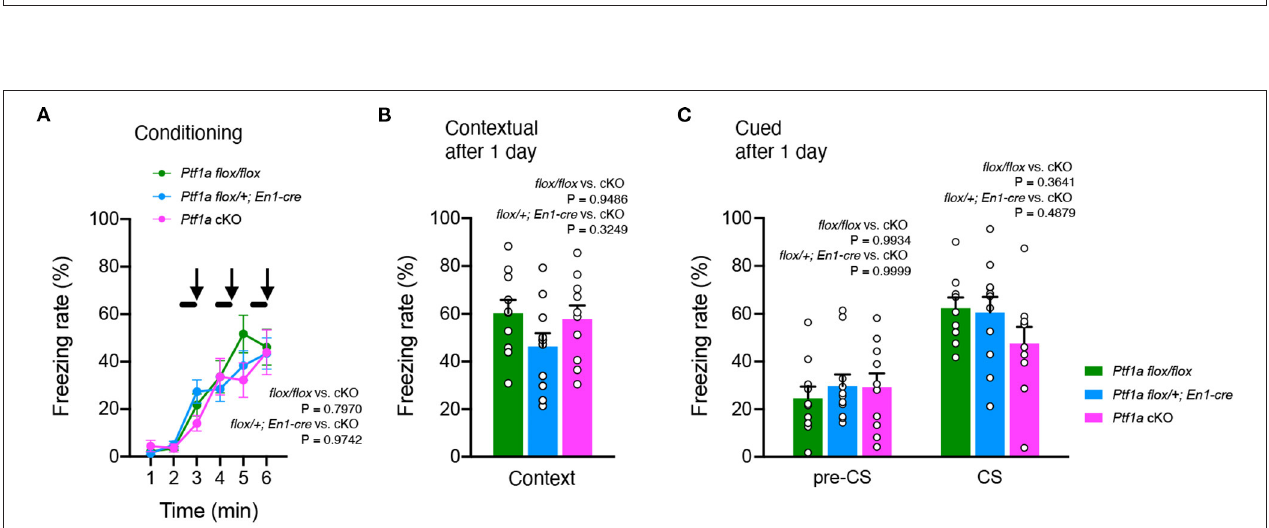
FIGURE 5 | No significant differences were observed in fear-conditioning behavior of adult male Ptf1a cKO mice. (A) A percentage of time showing freezing during the training phase of Ptf1a cKO and control mice. A tone was presented for 30s (black bars) followed by a 2s foot shock (black arrows). Mixed-effects analysis. (B,C) Freezing rate of Ptf1a cKO and control mice during the contextual test (B) and the tone-cued test with altered context (C) conducted at 1 day after conditioning. n = 10 for Ptf1a flox / flox , n = 11 for En1 cre / + ; Ptf1a flox / + , n = 10 for En1 cre / + ; Ptf1a flox / flox . Mixed-effects analysis. Data are the mean ± S.E.M.